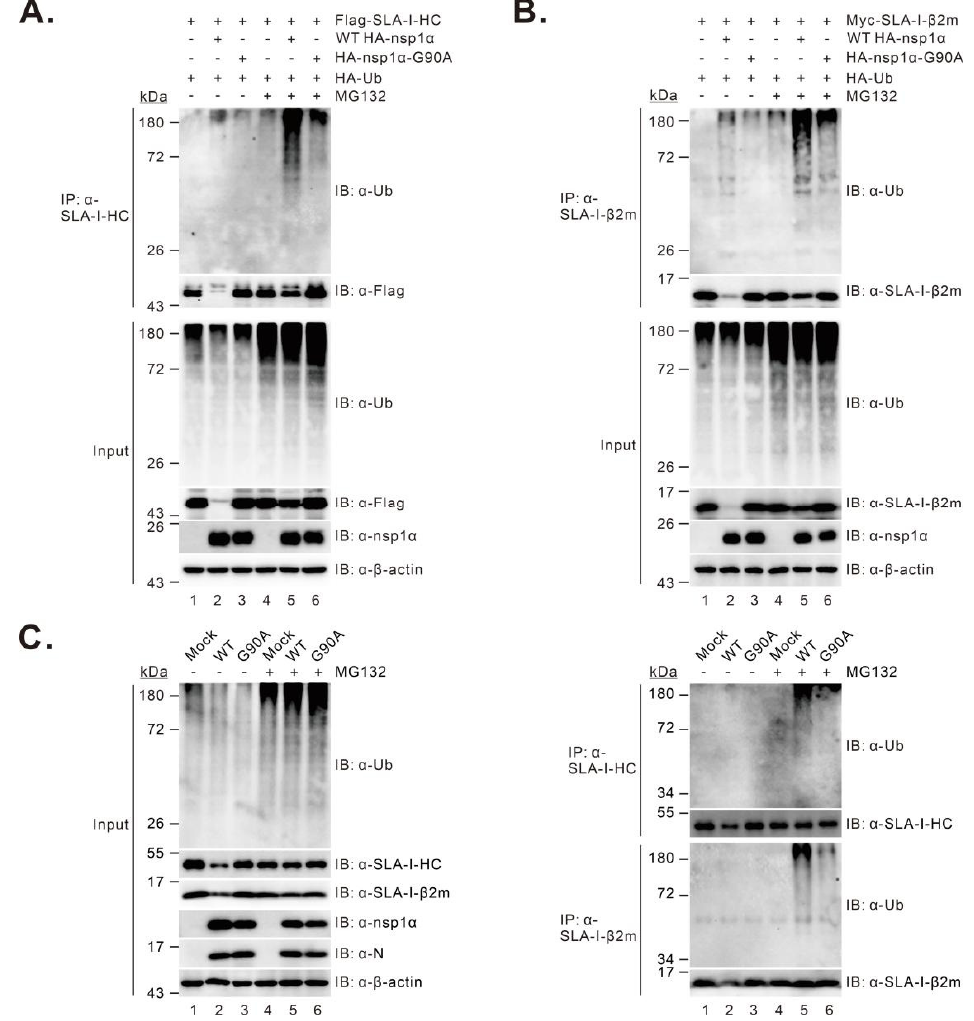
Figure 6. The effect of the G90A mutation on nsp1 α -induced SLA-I ubiquitination. ( A , B ) HEK 293T cells were co-transfected to express FLAG-SLA-I-HC ( A ) or Myc- β 2m ( B ), HA-ubiquitin with or without WT HA-nsp1 α or HA-nsp1 α -G90A. At 18-24 h post-transfection, the cells were treated with treated with MG132 at a final concentration of 10 µ M for 4 h before Co-IP and Western blot analyses with indicated antibodies. β -actin served as a loading control. ( C ) PAMs were mock-infected with RPMI 1640 or infected with 1.0 MOI of the WT or G90A. At 4–6 h post-infection, the cells were treated with 5 µ M MG132 for another 8 h before Co-IP and Western blot analyses with the indicated